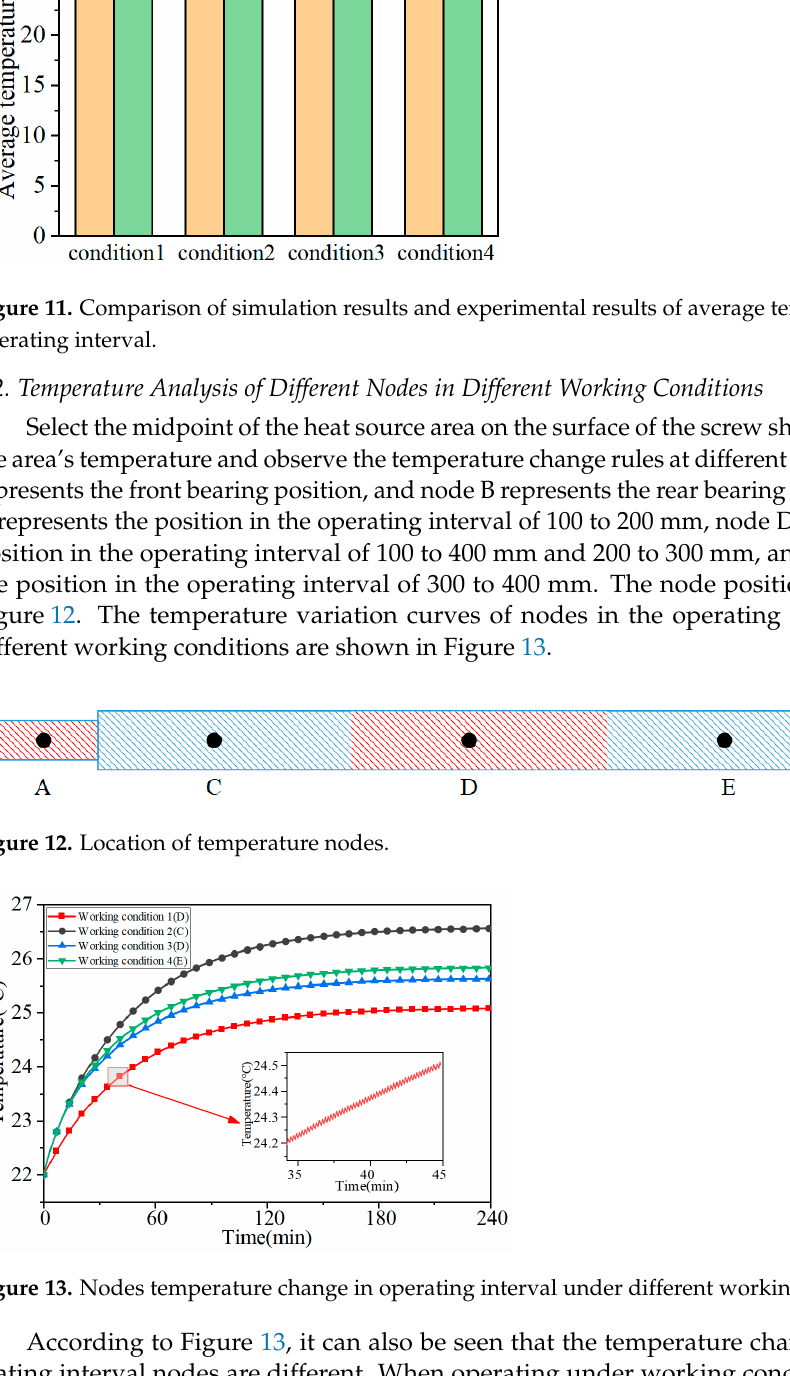
Figure 10. Temperature experimental results of the ball screw feed system under different working conditions: ( a ) working condition 1; ( b ) working condition 2; ( c ) working condition 3; and ( d ) working condition 4.